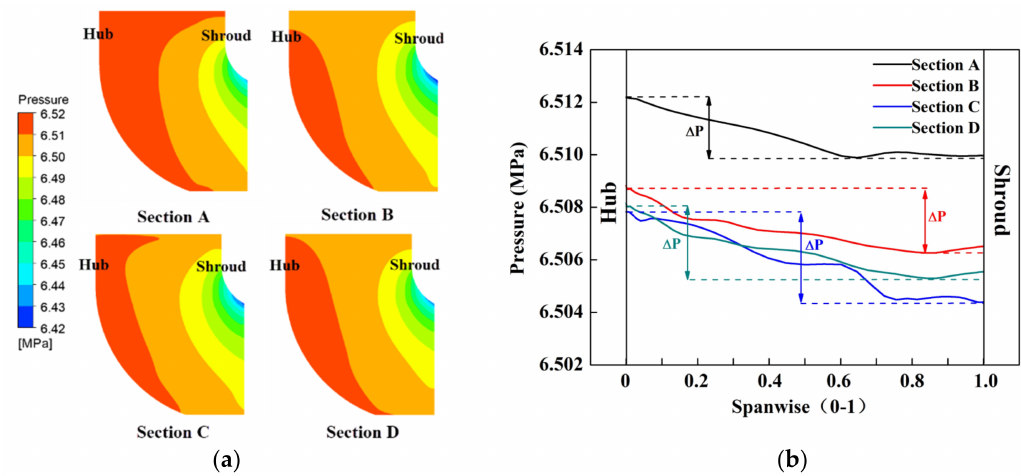
Figure 8. The ( a ) pressure contour and ( b ) distribution in the SIS